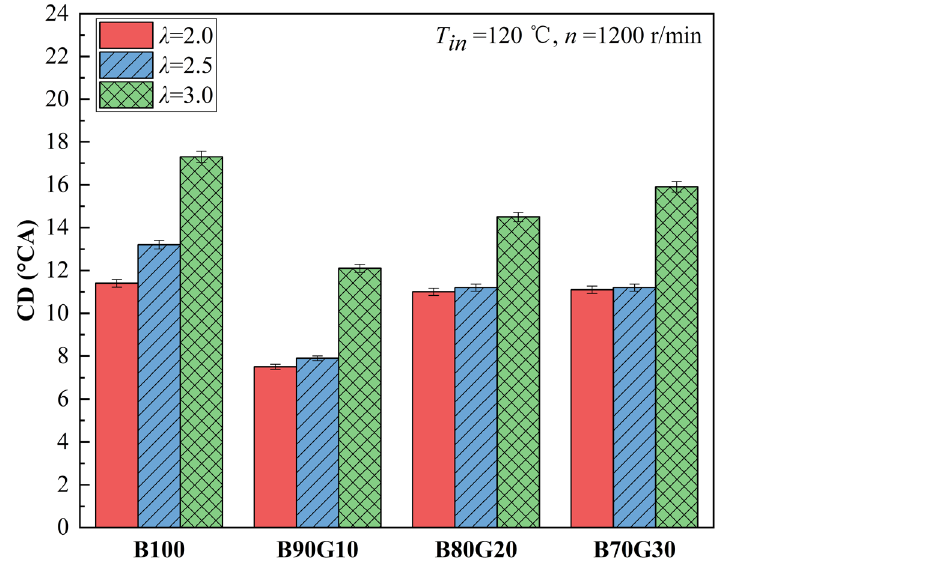
Figure 6. CD with different λ